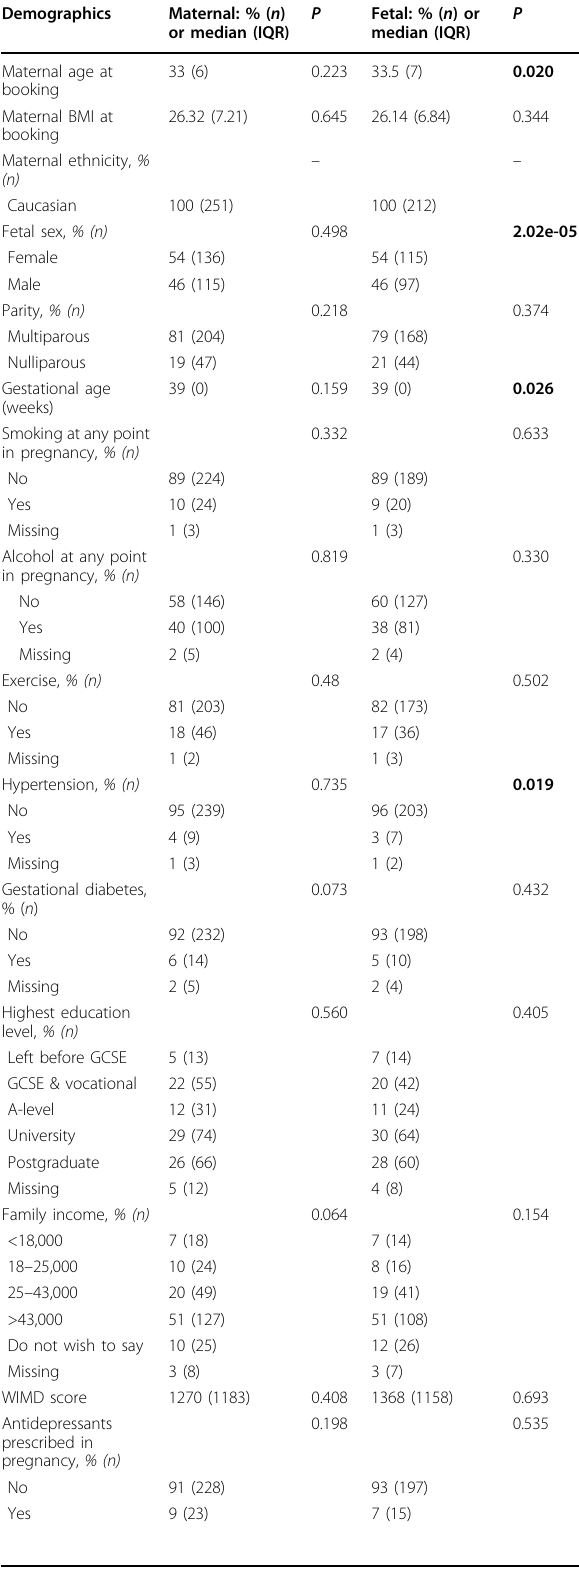
Table 1 Cohort demographic